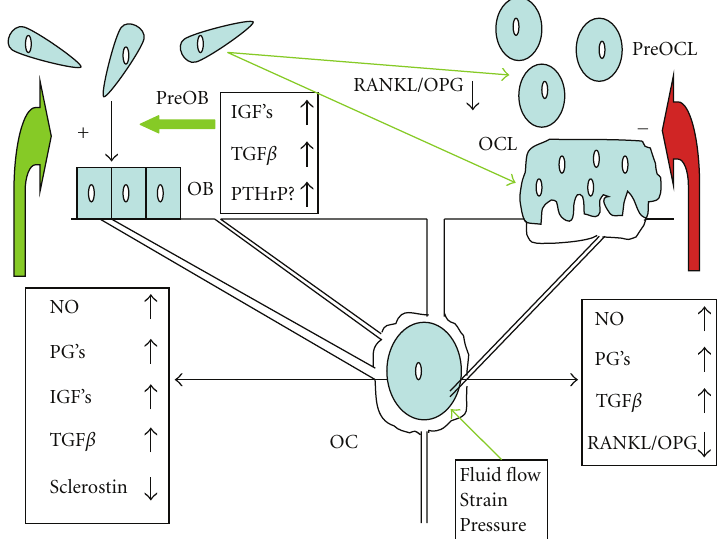
Figure 1: Mechanotransduction in bone. OC: osteocyte; OB: osteoblast; OCL: osteoclast; Pre-OB: preosteoblast; Pre-OCL: preosteoclast; PG’s: prostaglandin (E2 and I); RANK-L: receptor activating NF κ B-Ligand; OPG: osteoprotegerin; IGF: insulin-like growth factor; TGF: transforming growth factor; Scl: sclerostin; PTHrP: parathyroid hormone related peptide. Osteocytes sense the fluid flow induced by loading in the lacunocanalicular system; this signal modulates the secretion in the bone microenvironment of factors which can increase bone remodeling while stimulating osteoblast di ff erentiation and activity (green arrows) and decreasing osteoclast activity (red arrow), resulting locally in a positive bone balance.